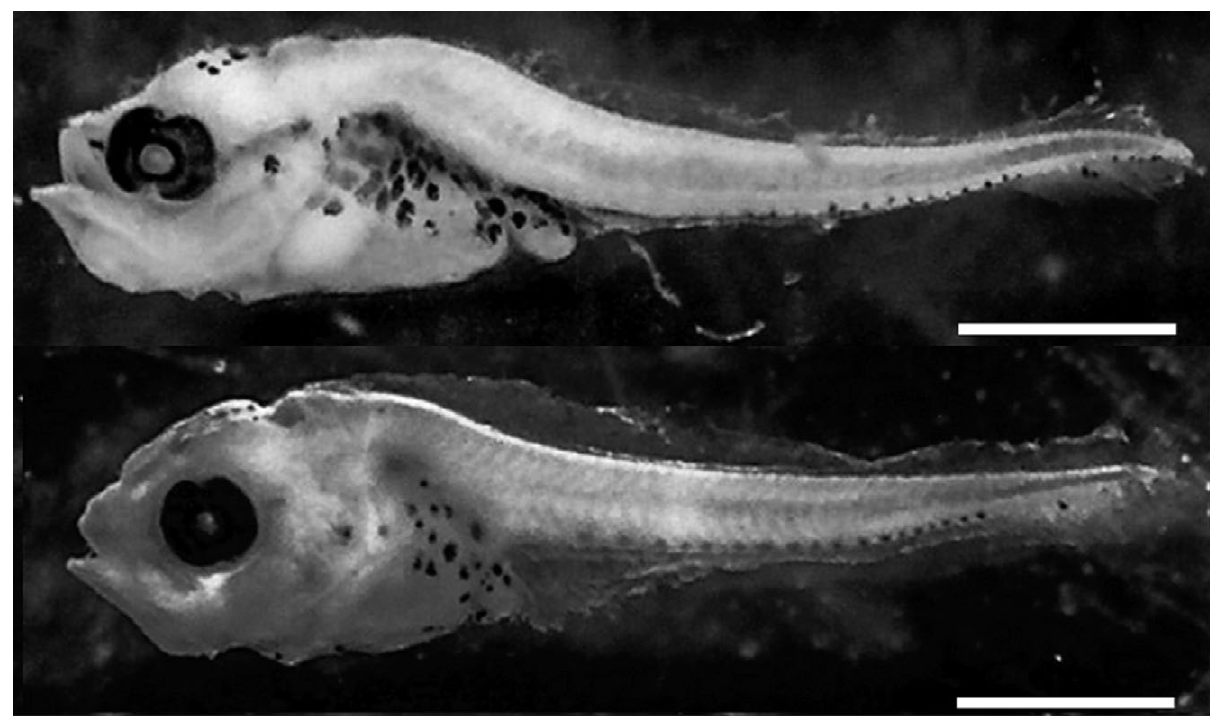
Fig 2. – Larval stages of sandperch collected off El Quisco Bay. Upper, Prolatilus jugularis ; Lower, Pinguipes chilensis. White bars cor- respond to 1 mm